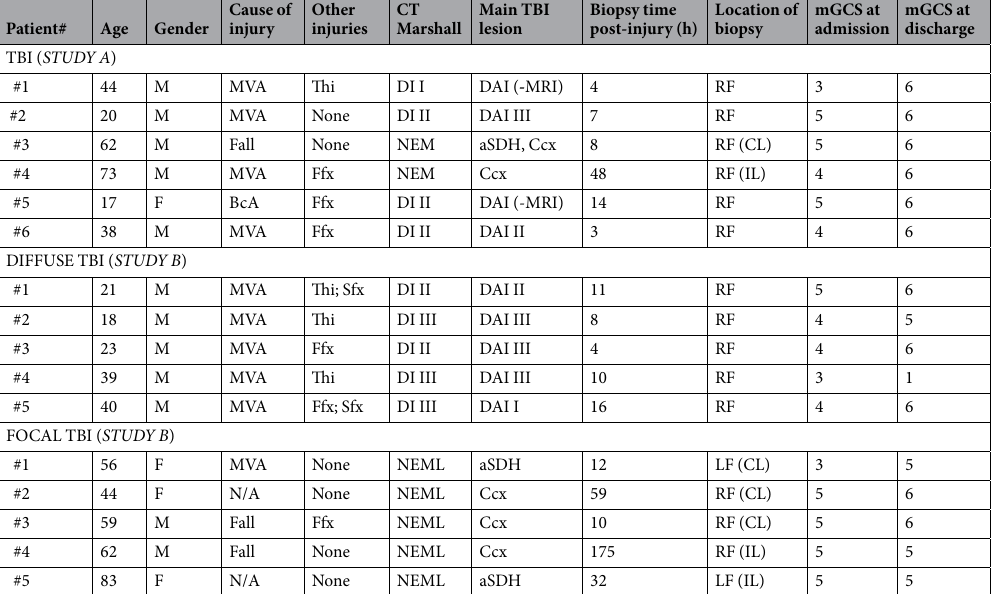
Proteome differences in a cohort of TBI and iNPH patients (Study A).